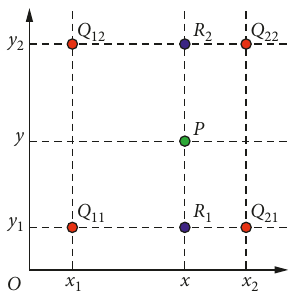
Figure 1: Bilinear interpolation.